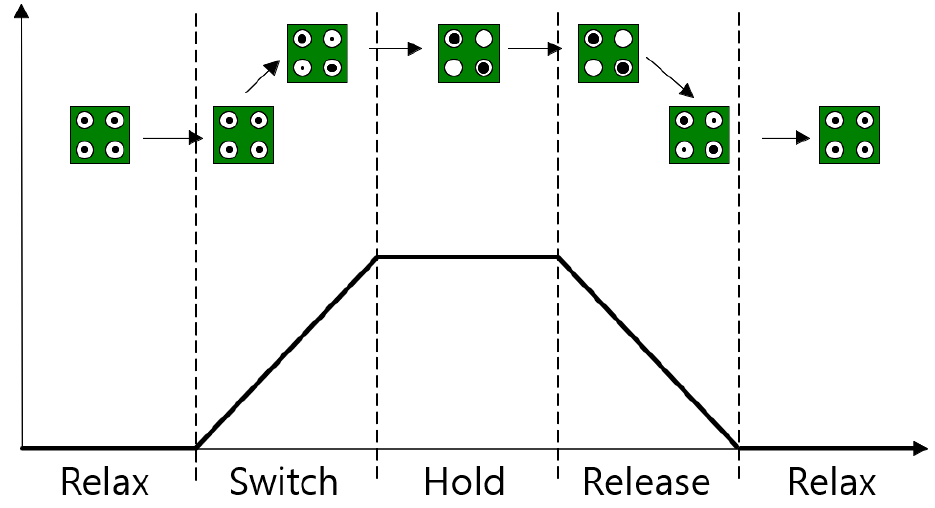
Figure 5. Four states of the QCA clock .